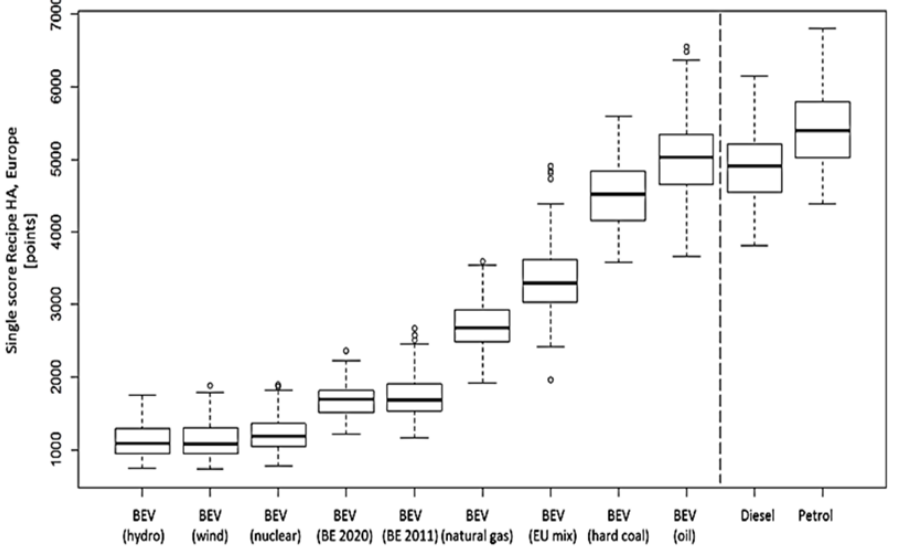
Figure 10. Results of single-score LCA [8].